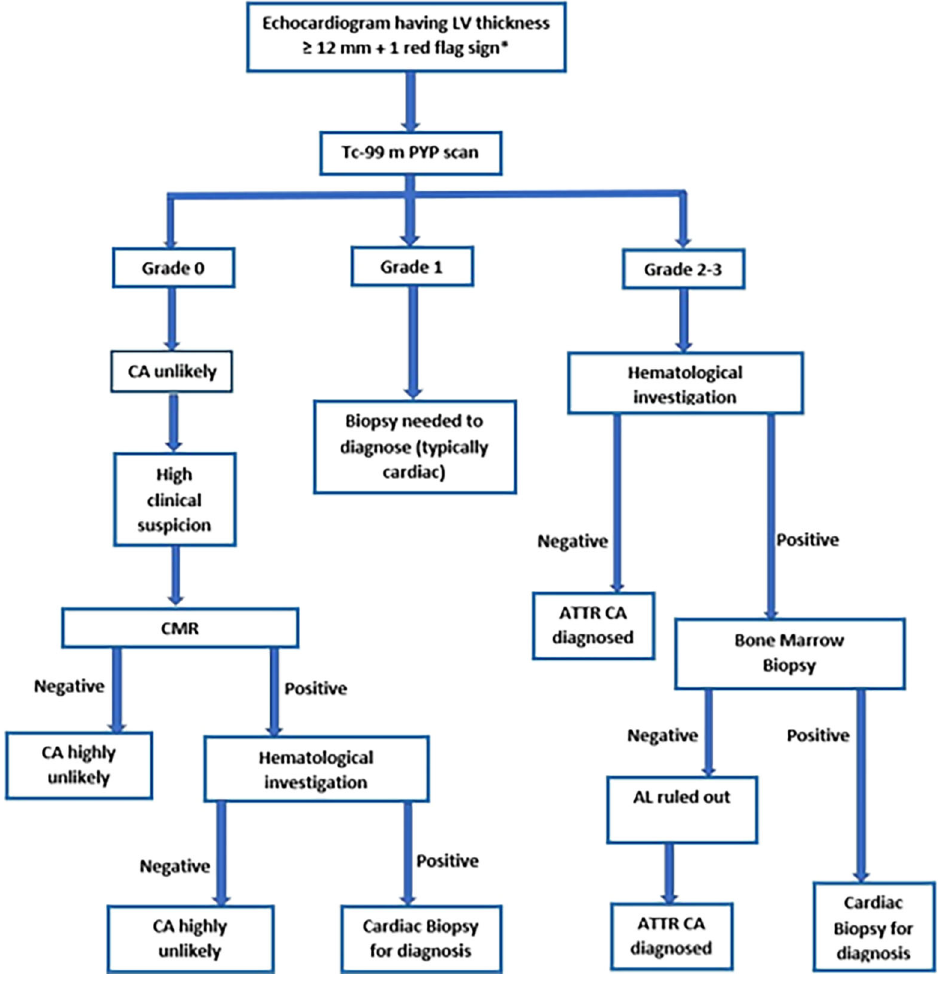
Figure 1. Patient selection and study design. LV-left ventricle, Tc-99m PYP-Technetium-99m pyrophosphate, CA-cardiac amyloidosis, CMR-cardiac magnetic resonance, ATTR- transthyretin amyloidosis, AL-amyloid with light chain *Red flags - heart failure ≥ 65 years, aortic stenosis ≥ 65 years, hypotension or normotensive if previously hypertensive, sensory involvement, autonomic dysfunction, peripheral polyneuropathy, proteinuria, skin bruising, bilateral carpal tunnel syndrome, ruptured biceps tendon, subendocardial/transmural late gadolinium enhance- ment or increased extracellular volume fraction, reduced longitudinal strain with apical sparing, decreased QRS voltage to mass ratio, pseudo Q waves on ECG, atrioventricular conduction disease, possible family